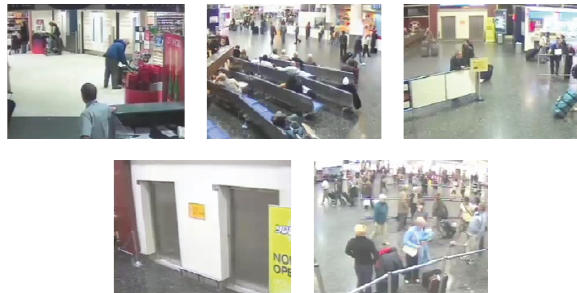
Figure 3: Samples of TRECVID